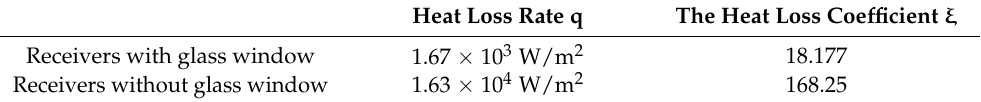
Table 1. Value of the heat loss coefficient ξ = q/DNI used for two kinds of